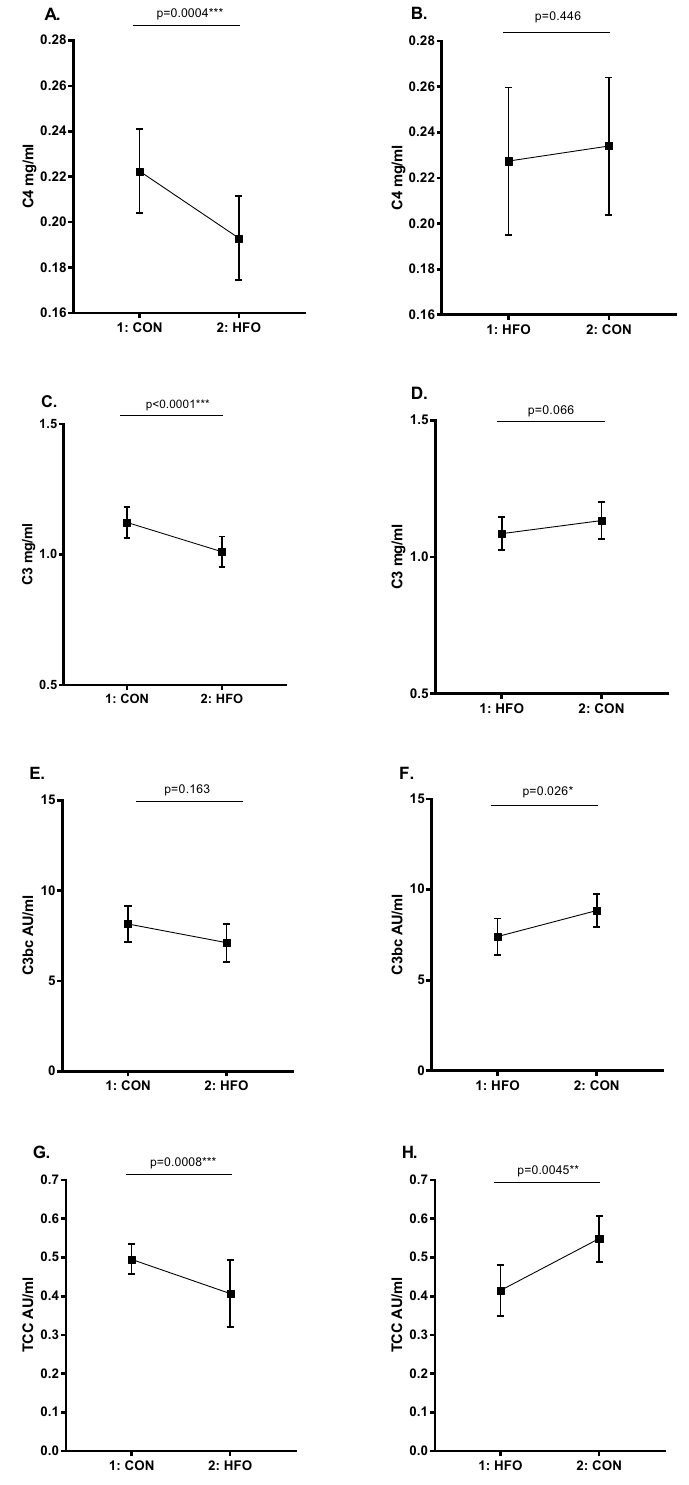
Figure 2. Reversibility of the impact of short term high-fat overfeeding on circulating C4, C3, C3bc and TCC. Comparison of the subjects that received the control diet first (n = 24) and the high-fat overfeeding diet 6–8 weeks after (diagram A , C , E , G ), with the subjects that received the high-fat overfeeding first (n = 19) and the control diet 6–8 weeks after (diagram B , D , F , H ). Data are reported as means with 95% CI. Paired two-tailed t-test p-values represent the difference in serum/plasma concentration of the different complement factors after control diet vs. after overfeeding. Please note the Y-axis benchmark in diagram ( A and B ) is 0.16, in diagram ( C and D ) 0.5, and in diagram ( E , F , G and H ) 0. AU, arbitrary units; CON, control diet; HFO, high-fat overfeeding; 1 = first study period; 2 = second study